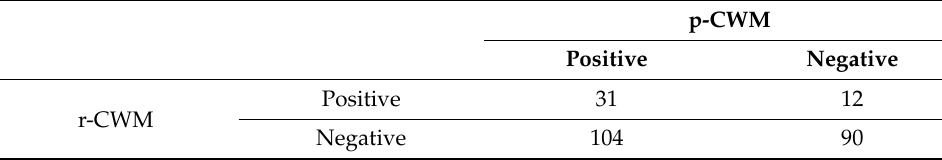
Table 2. Correlations between radiological findings and p-CWM.